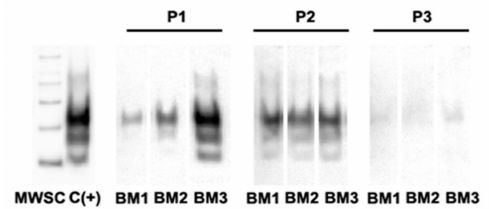
Figure 3. Determination of PrP Sc by Western blotting in oBM-MSCs (BM1, BM2, BM3) in- fected with scrapie inocula at passages 1 to 3 (P1, P2, P3). MWSC = molecular weight marker; C (+) = positive